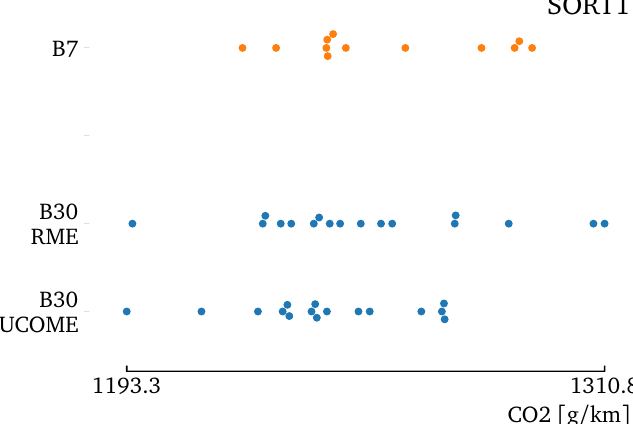
Figure 16. No considerable difference in CO2 tailpipe emissions is measured during SORT 1 when the bus is fueled with B30 RME, B30 UCOME and B7. The maximum measurement uncertainty with 95% probability amounts to 10.7 g/km